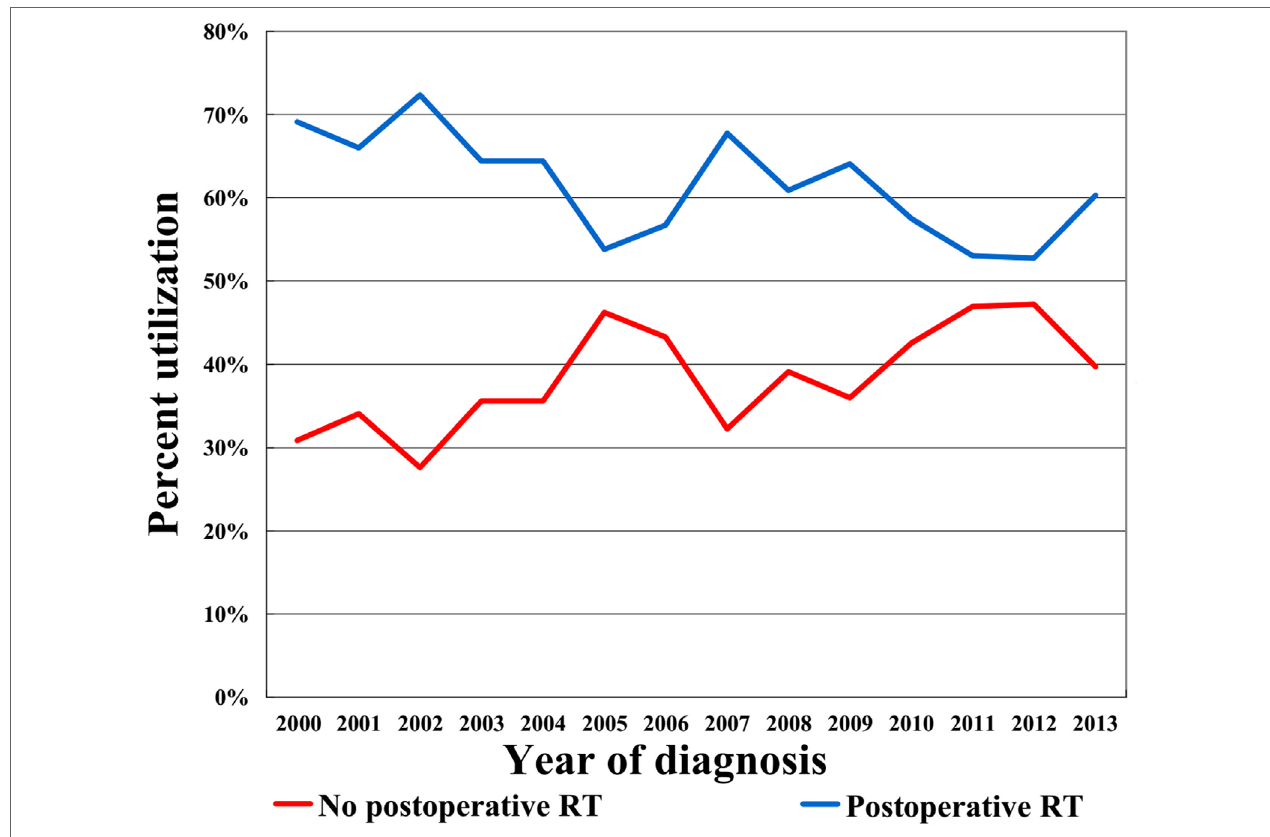
Figure 1 | Utilization of postoperative radiotherapy vs. omission during the study period.